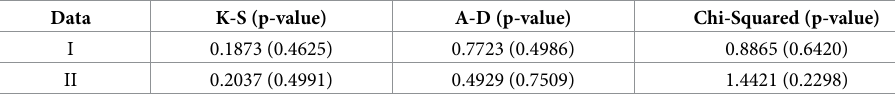
Table 11. Test statistic and p-value associated with each test for example 1.